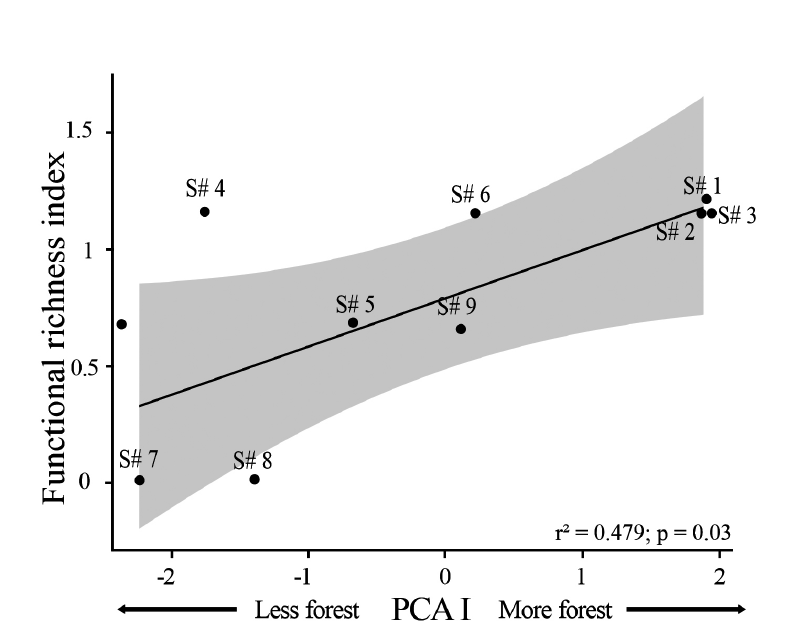
FIGURE 6 | Relationship between forest cover and the functional richness index observed in streams located in the Tanguro Farm, municipality of Querência, state of Mato Grosso. Forest cover is represented by the Axis I of the PCA performed with land use variables obtained from a 60 m buffer. Sites 1, 2 and 3 overlapped and were rearranged for better visualization.